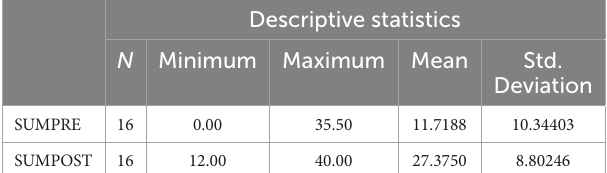
TABLE 7 Descriptive statistics for pre-efficacy and post-efficacy scores for scaffolded group. Descriptive statistics